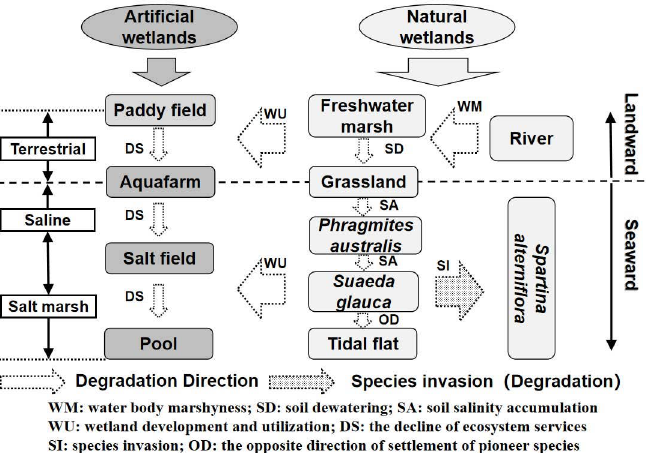
Figure 2. Directional succession model of coastal wetland landscape in Jiangsu Province,